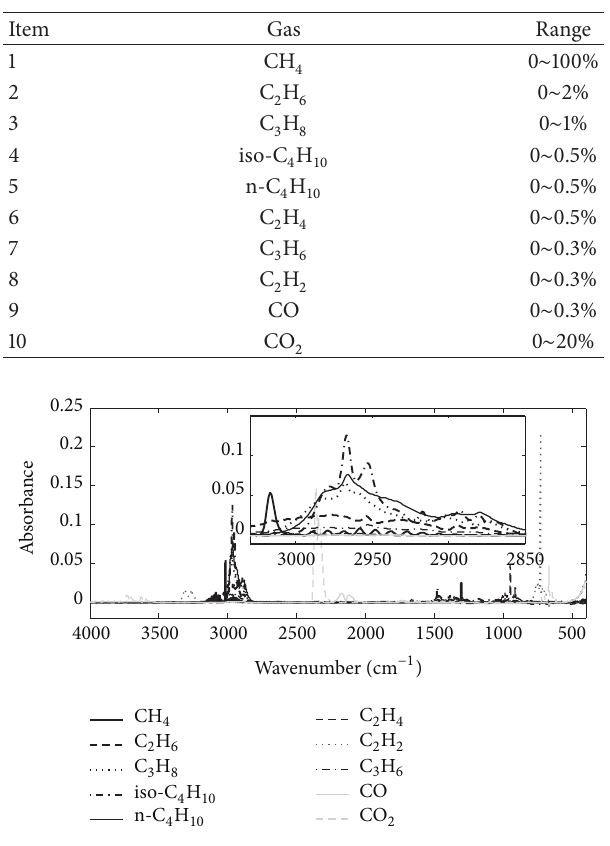
Figure 3: Absorption spectra of analytes with concentration of 1000